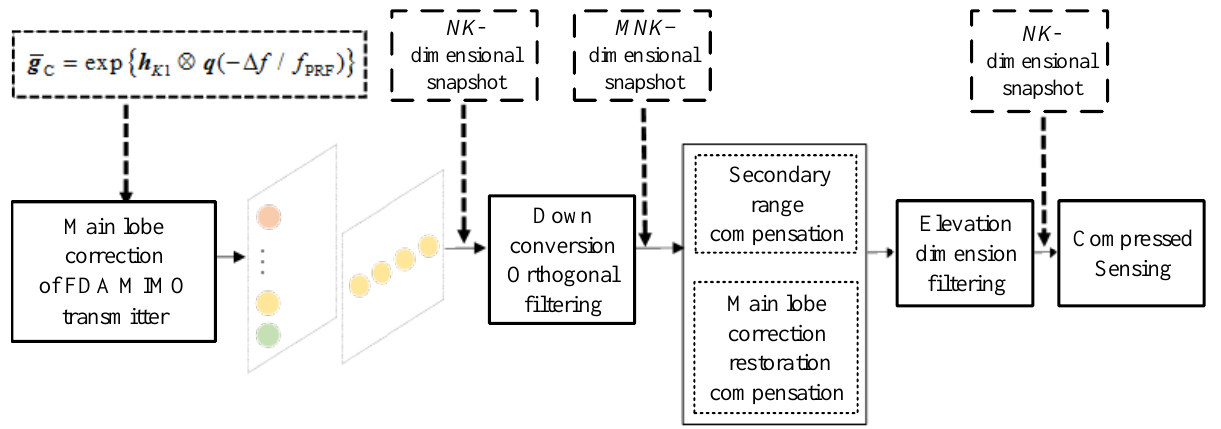
Figure 8. Compressed sensing MLC FDA radar signal processing flow chart.